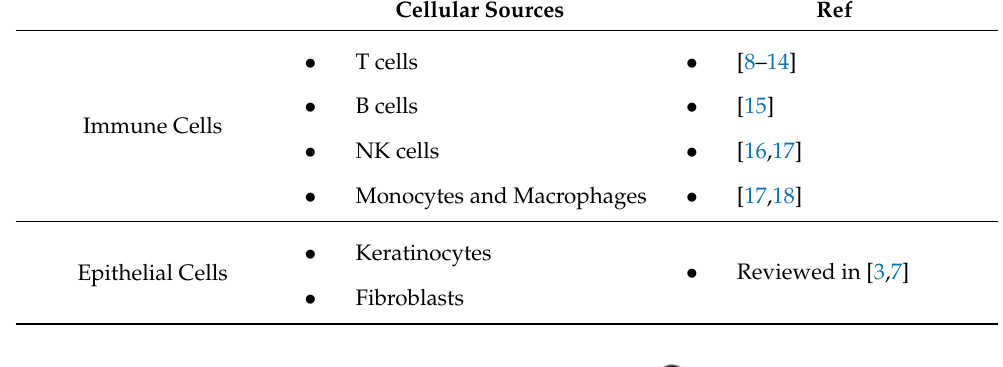
Table 1. The cellular sources of IL-24.